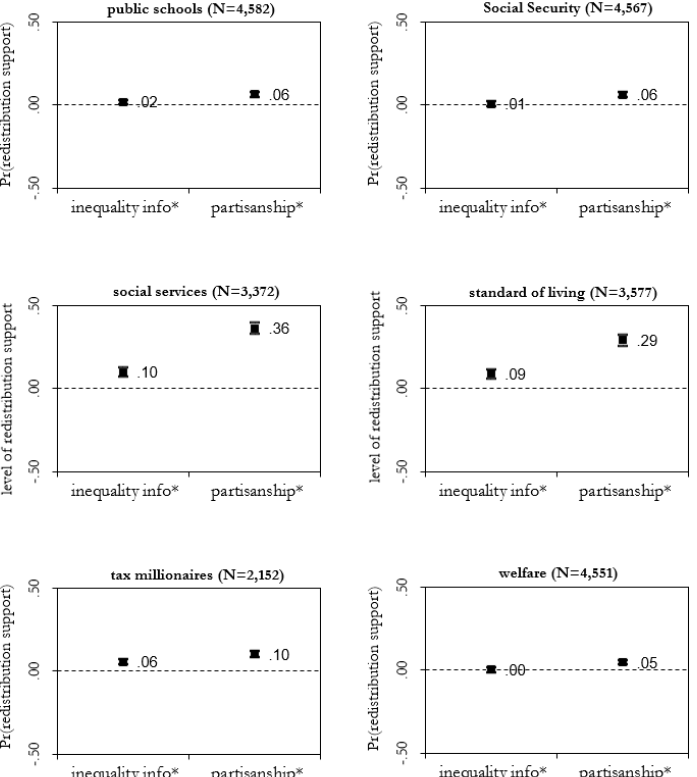
Figure 2. Average marginal effects of inequality information and partisanship on redistribution preferences, American National Election Studies 2004–2016. Estimates are average predicted change in standardized level/probability of redistribution support due to a one standard unit increase in inequality information or partisanship (95% confidence intervals indicated by bars). An asterisk indicates that estimates differ ( p < 0.05).